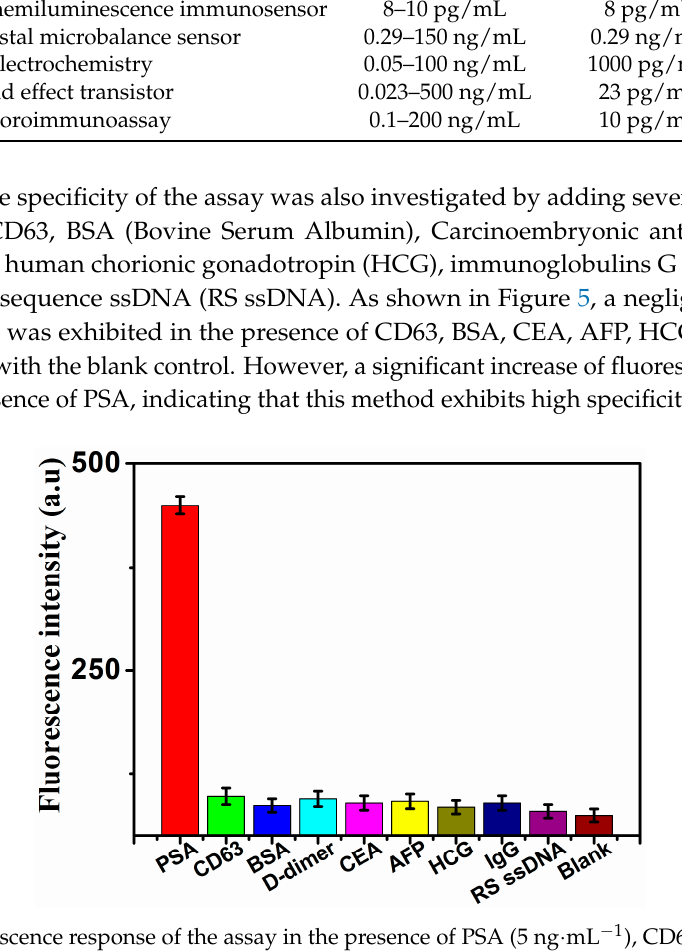
Figure 5. Fluorescence response of the assay in the presence of PSA (5 ng · mL − 1 ), CD63 (50 ng · mL − 1 ),